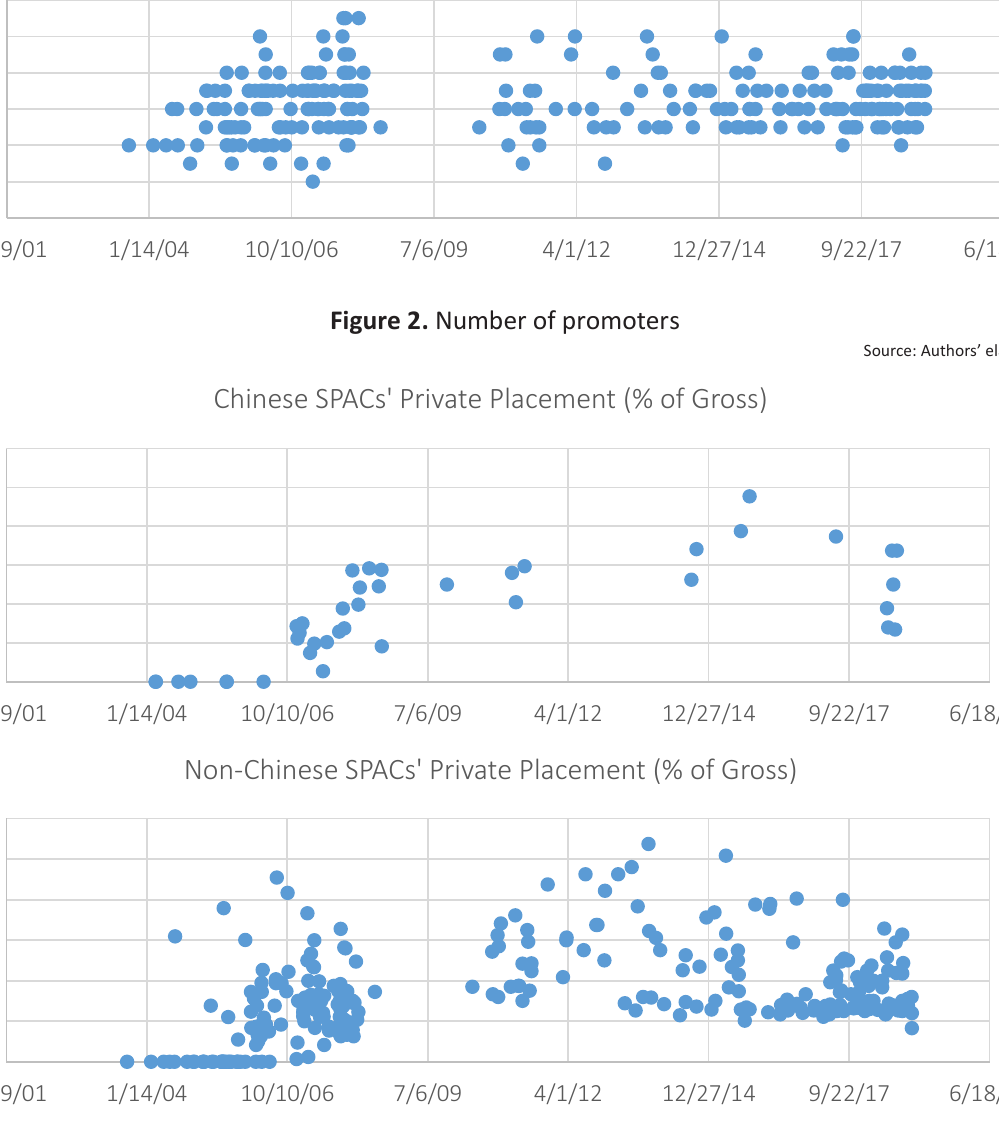
Figure 3. Private placement